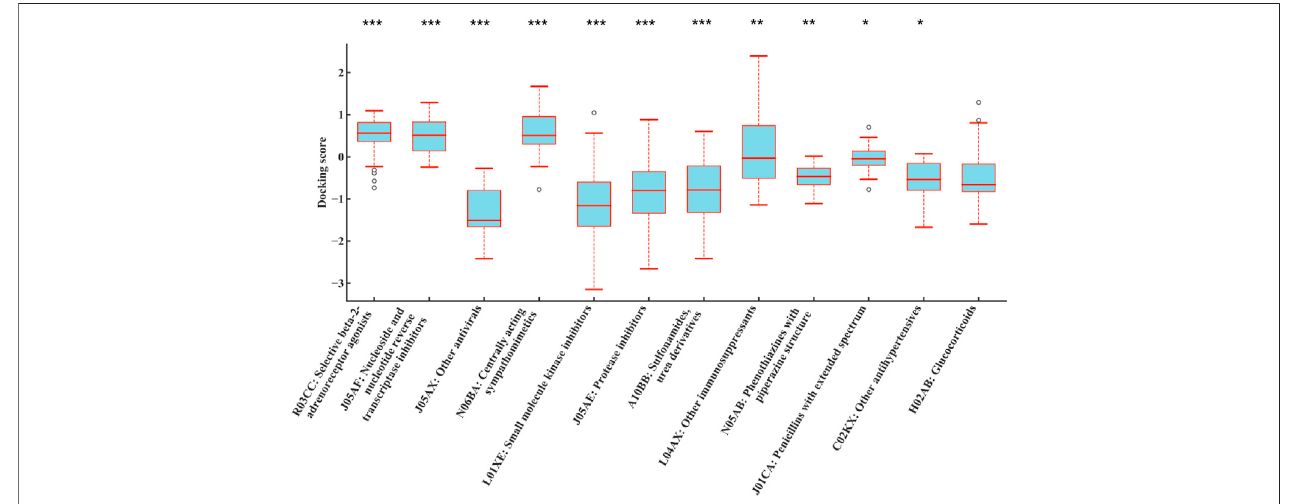
FIGURE 5 | Distributions of normalized average docking scores between different drug class and 7 CYP family enzymes (CYP3A4, CYP3A5, CYP2C9, CYP2E1, CYP2C19, CYP1A2, and CYP2D6). The y -axis indicates the normalized average docking scores. The x -axis represents different ATC code categories. Drugs with ATC code L01XE were all signi fi cantly different against other groups ( p = 1.07E-09) (ANOVA). It indicated that the result scores of KIs (ATC code: L01XE) were signi fi cantly better(lower inscores) thanthoseofother types, whichindicatesthatKIs maybind toCYP family enzymes and metabolized thus increasedpotentialforDILI. #The results were sorted by signi fi cance from high to low, and only the fi rst 12 were shown. *** p < 0.001; ** p < 0.01; * p < 0.05.